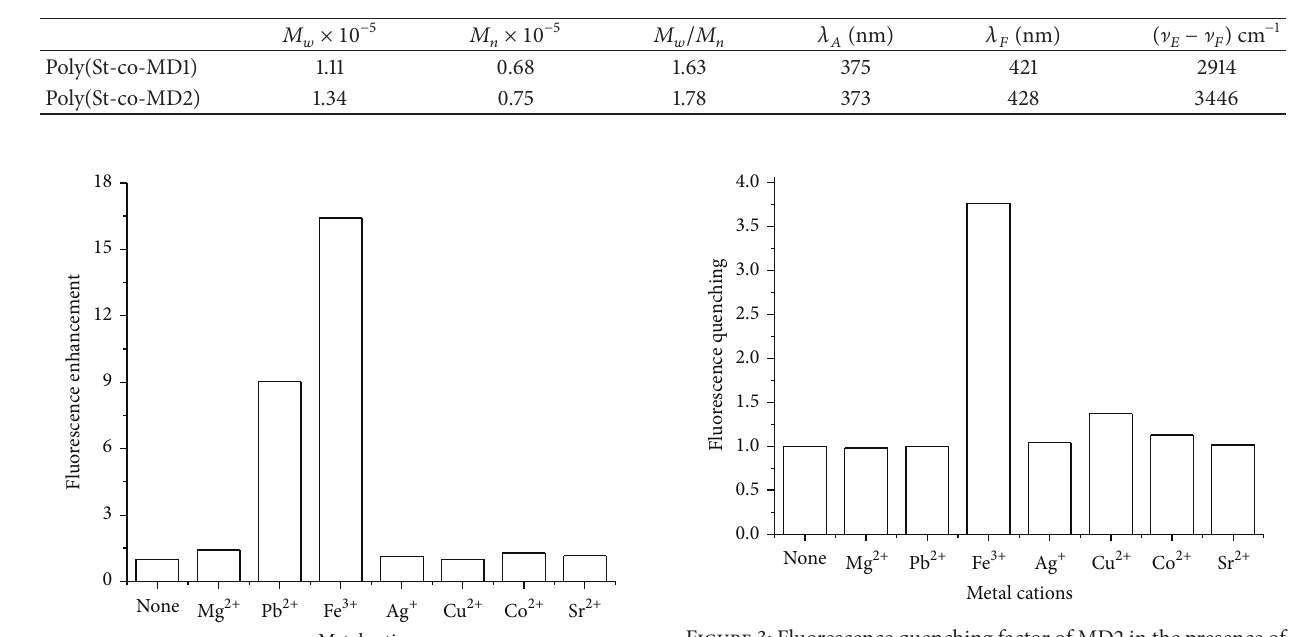
Figure 3: Fluorescence quenching factor of MD2 in the presence of different metal cations ( 𝑐 = 2×10 −5 mol L −1 ) in acetonitrile